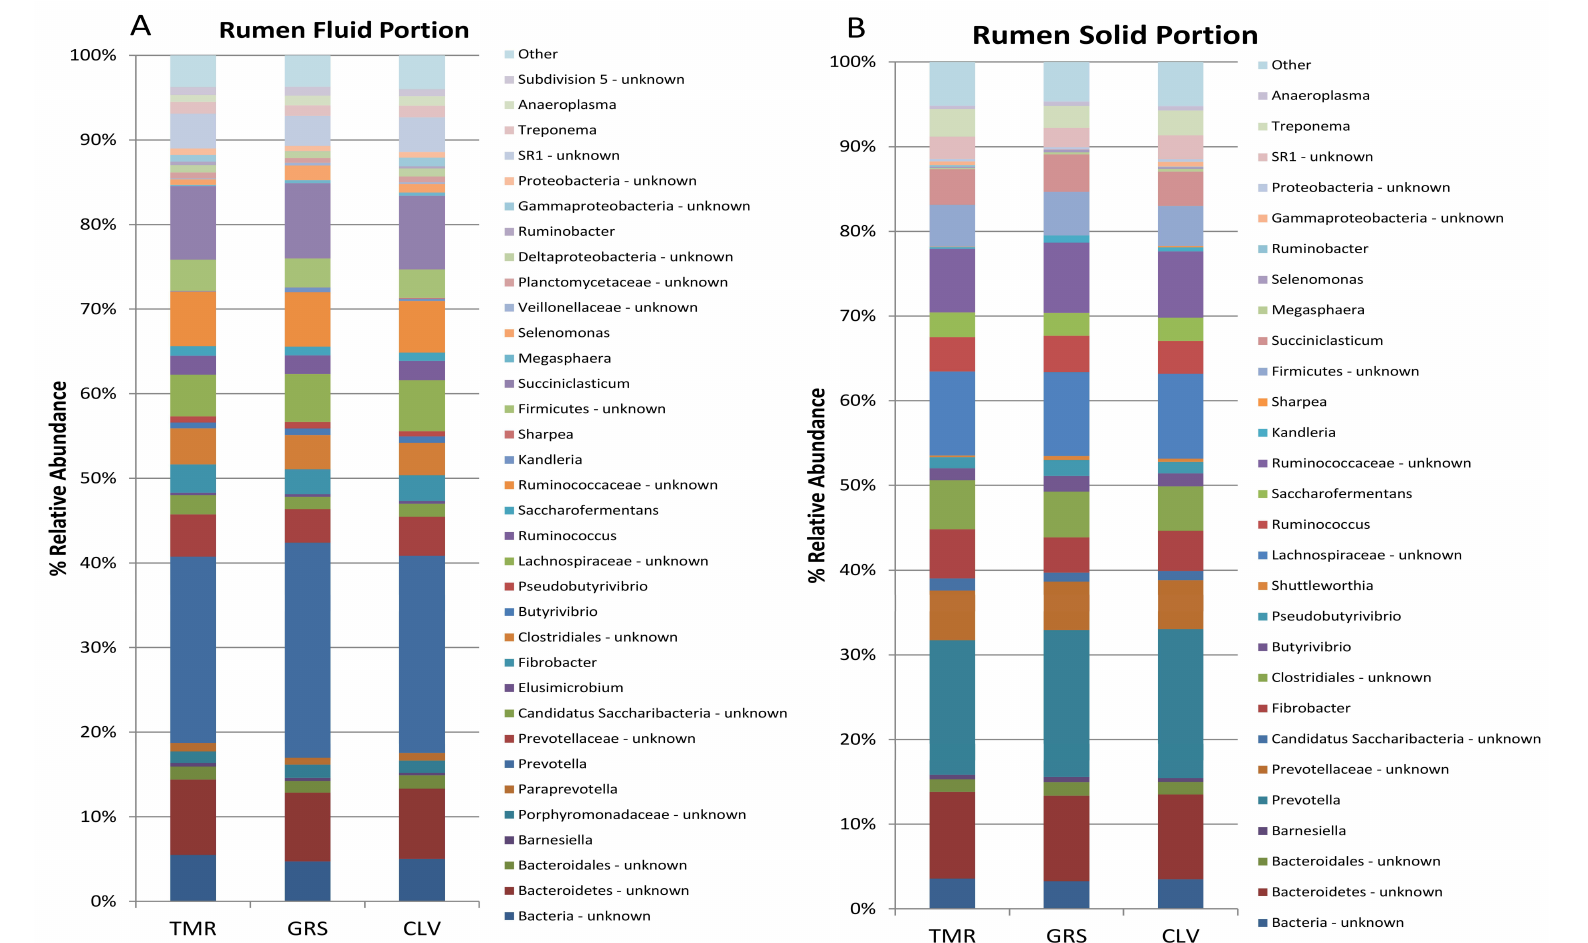
Figure 2. Bar chart demonstrating breakdown of abundances of different genera in rumen fluid ( A ) and rumen solid ( B ) portions of rumen microbiota. (Genera present at > 1% abundance in at least 1